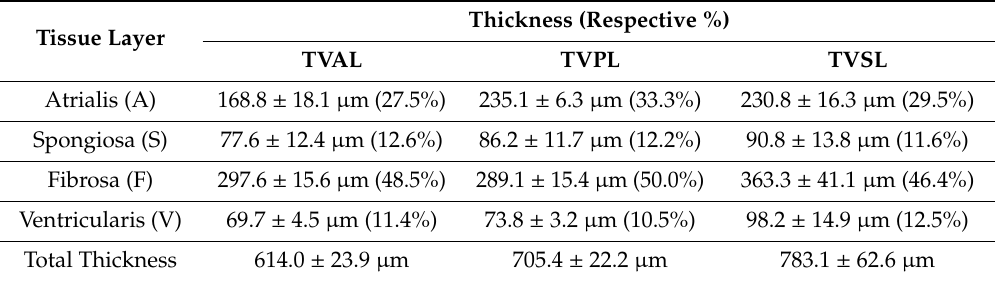
Table 2. Histologically quantified thickness and percent composition of the four tissue layers (i.e., atrialis, spongiosa, fibrosa, and ventricularis) for the TVAL, TVPL, and TVSL specimens. Values are reported as mean ± SEM ( n = 3).